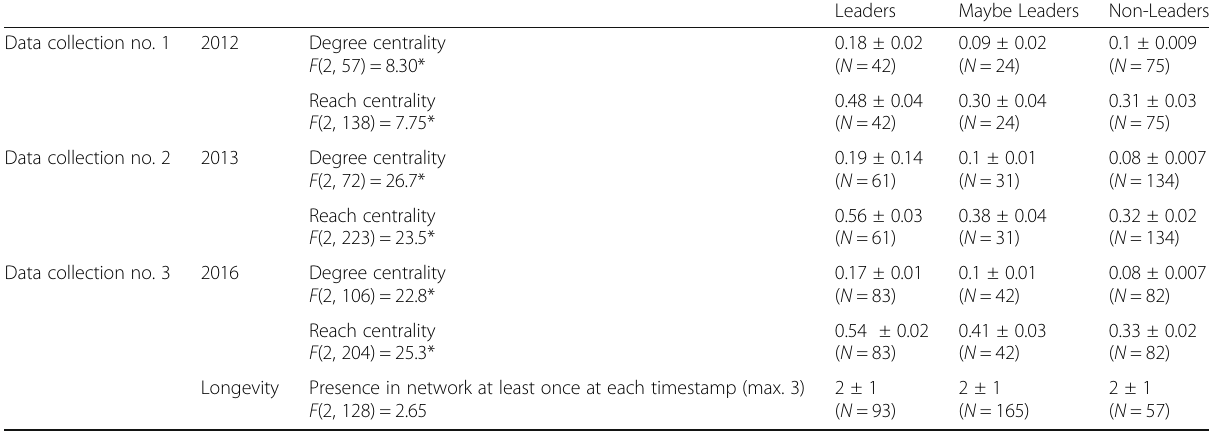
Leaders Maybe Leaders Non-Leaders